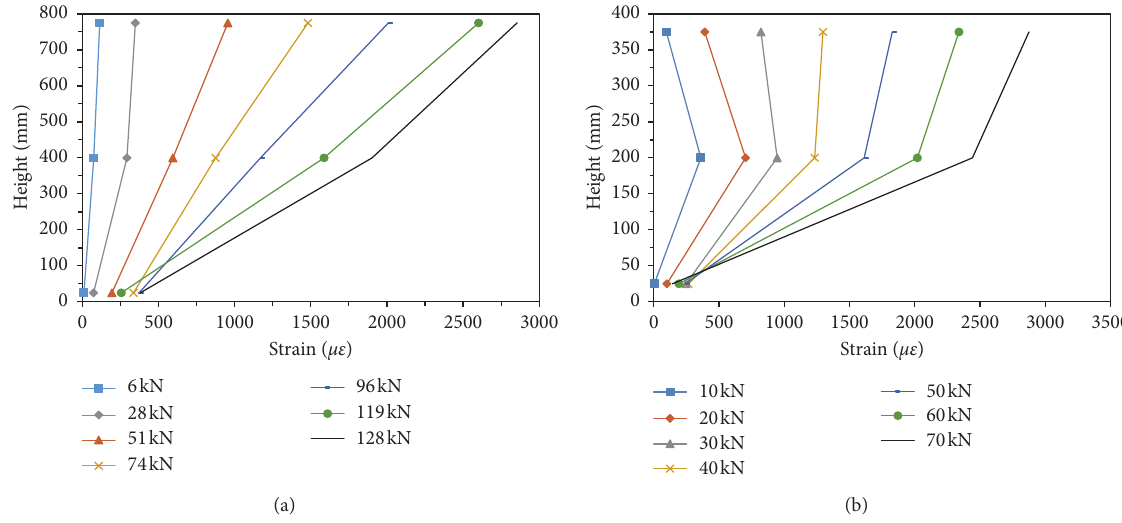
Figure 16: Strain height of FRP tube curves of specimens with shear connectors. (a) 4-3. (b) P-3.